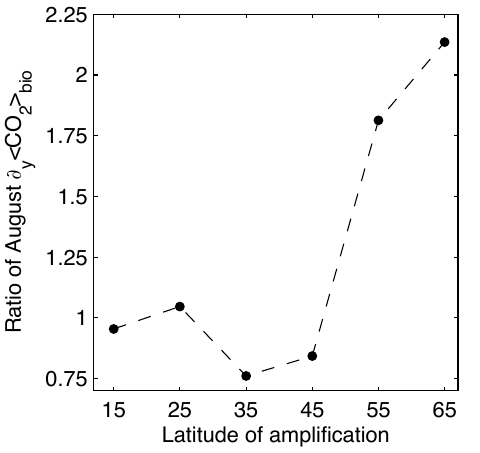
Fig. 13. August \ ∂ y h CO 2 i bio estimated at Park Falls, Wisconsin as NEE is amplified in the 10 ◦ bands shown in Table 2. The estimated gradient remains essentially the same when fluxes are amplified to the south of the site, whereas the gradient doubles when fluxes are amplified north of the site. Enhancing NEE north of the site draws down h CO 2 i during August, leading to a larger north-south gradi- ent.